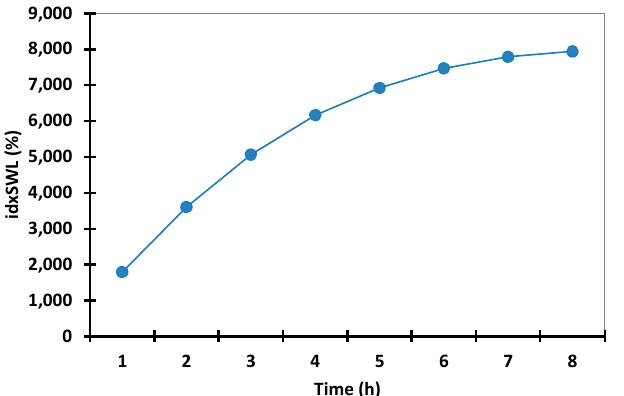
Figure 2. Interval plots of the microspheres’ swelling index (idxSWL (%)) from microspheres for Time factor levels.